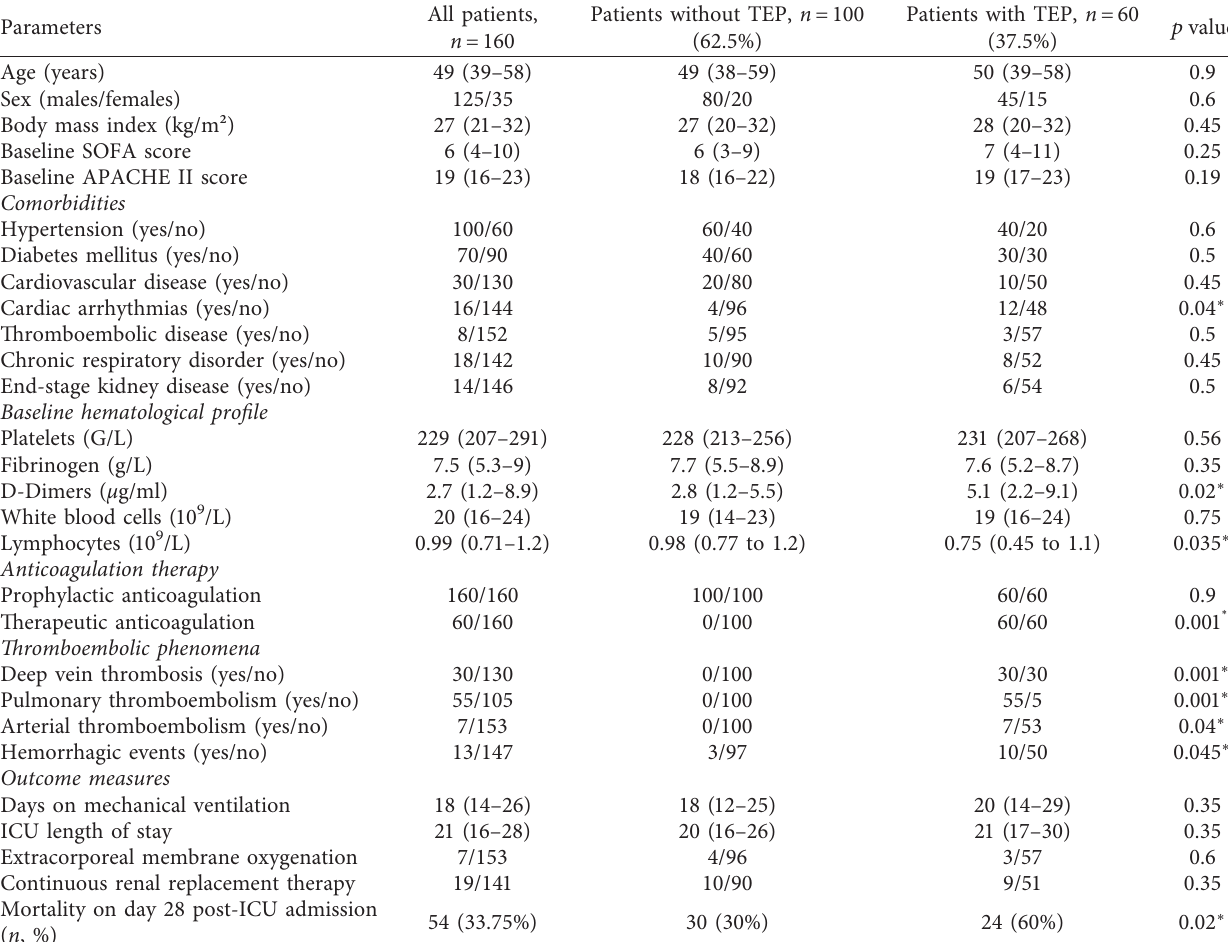
Table 1: Characteristics of critically ill patients with COVID-19 who developed ( n � 60, 37.5%) or not ( n � 100, 62.5%) thromboembolic